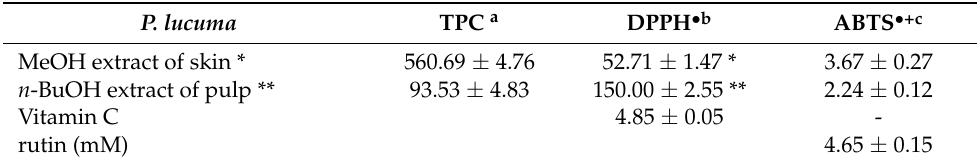
Table 1. Total phenolic content (TPC), DPPH • and ABTS • + radical scavenging activity of the extracts of P. lucuma pulp and skin evaluated by spectrophotometric